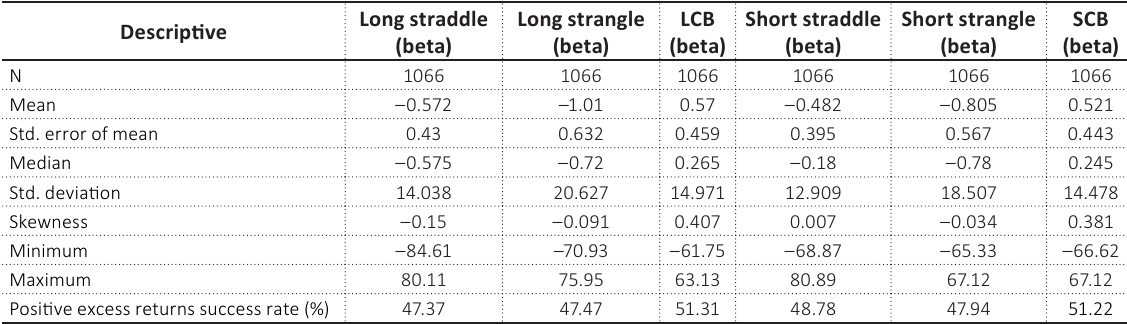
Table 9. Excess returns to beta in volatile market